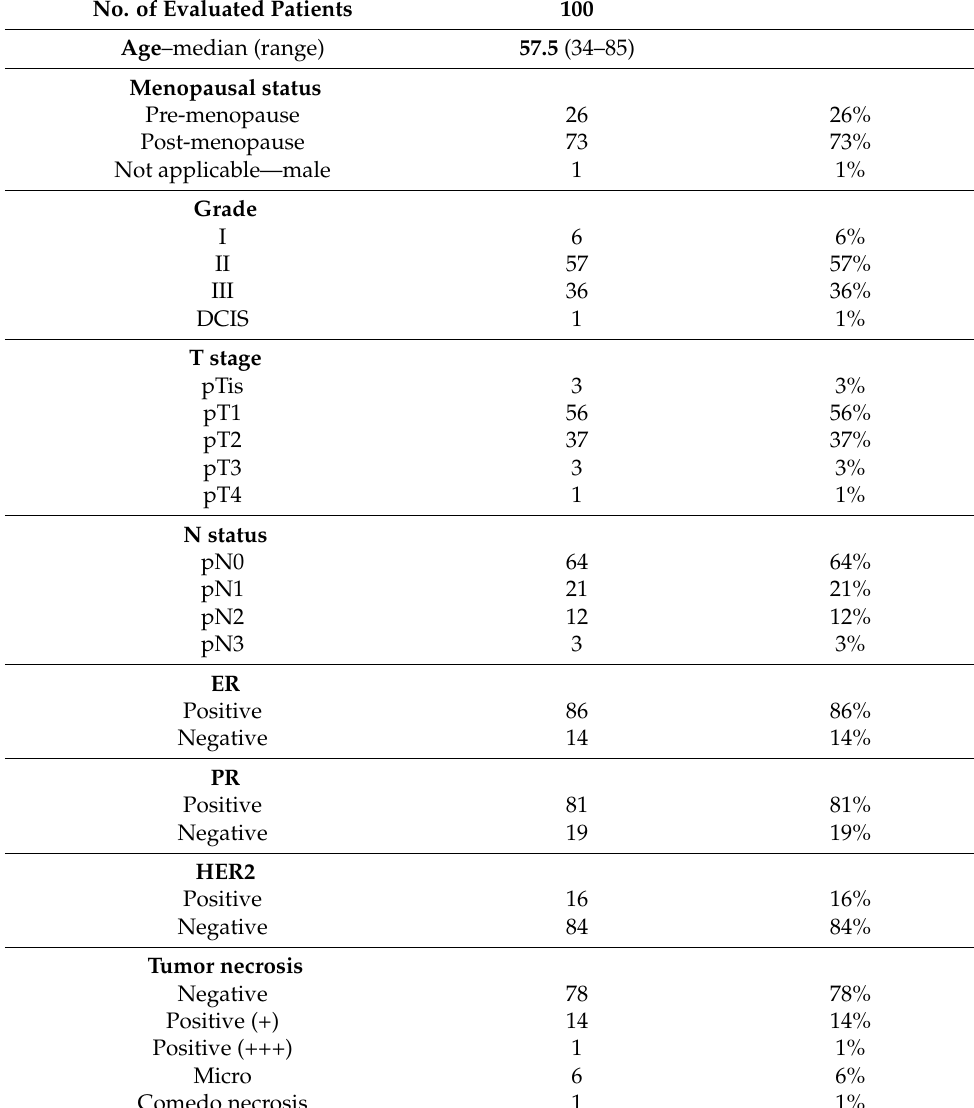
Table 1. Patient